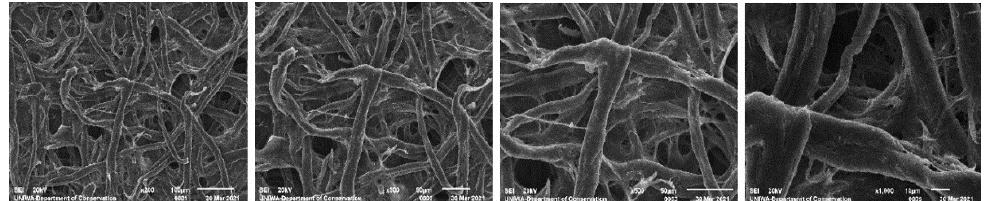
Figure 5. SEM images of cotton paper, 0 days of ageing, at 200, 300, 500, and 1000× magnification (left to right).